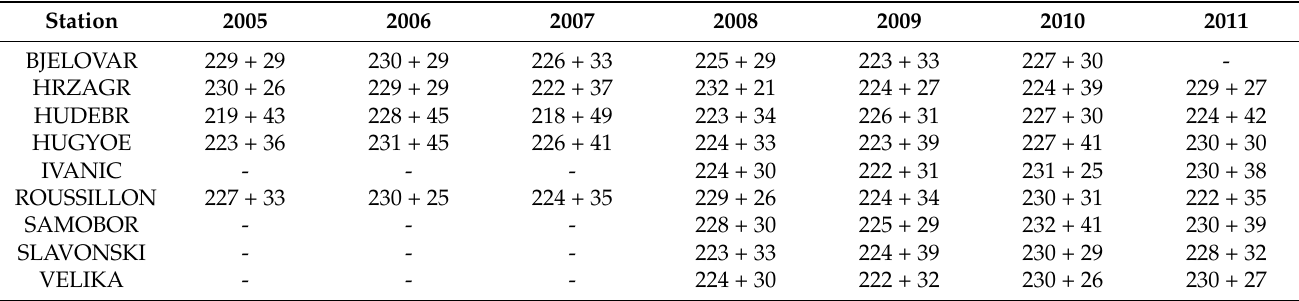
Table 2. Julian day for the start of the pollen season (day when 5% of the annual pollen sum is reached) and number of days of the season (between 5% and 95% of the annual pollen sum). The empty lines are for stations and years with no data, as explained in Table